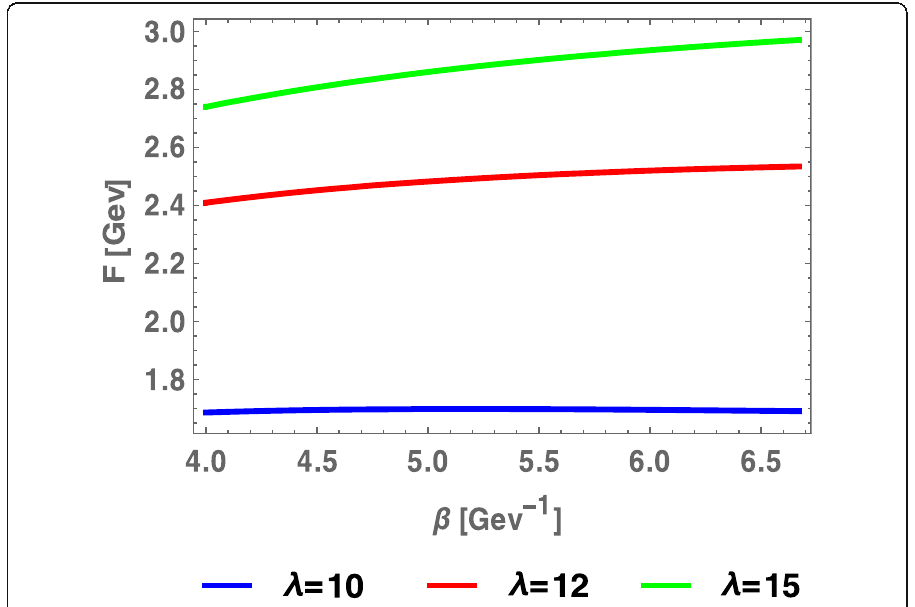
Fig. 7 Free energy F is plotted against β for different values